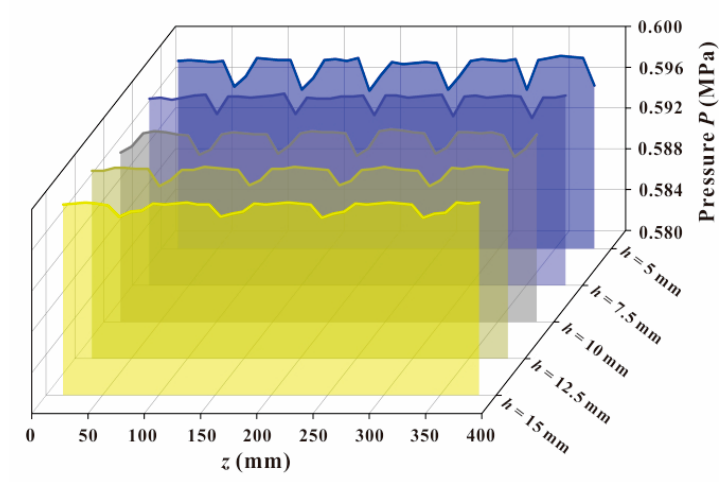
Figure 9. Pressure distribution with a fin pitch p = 20 mm and fin thickness t = 2 mm.